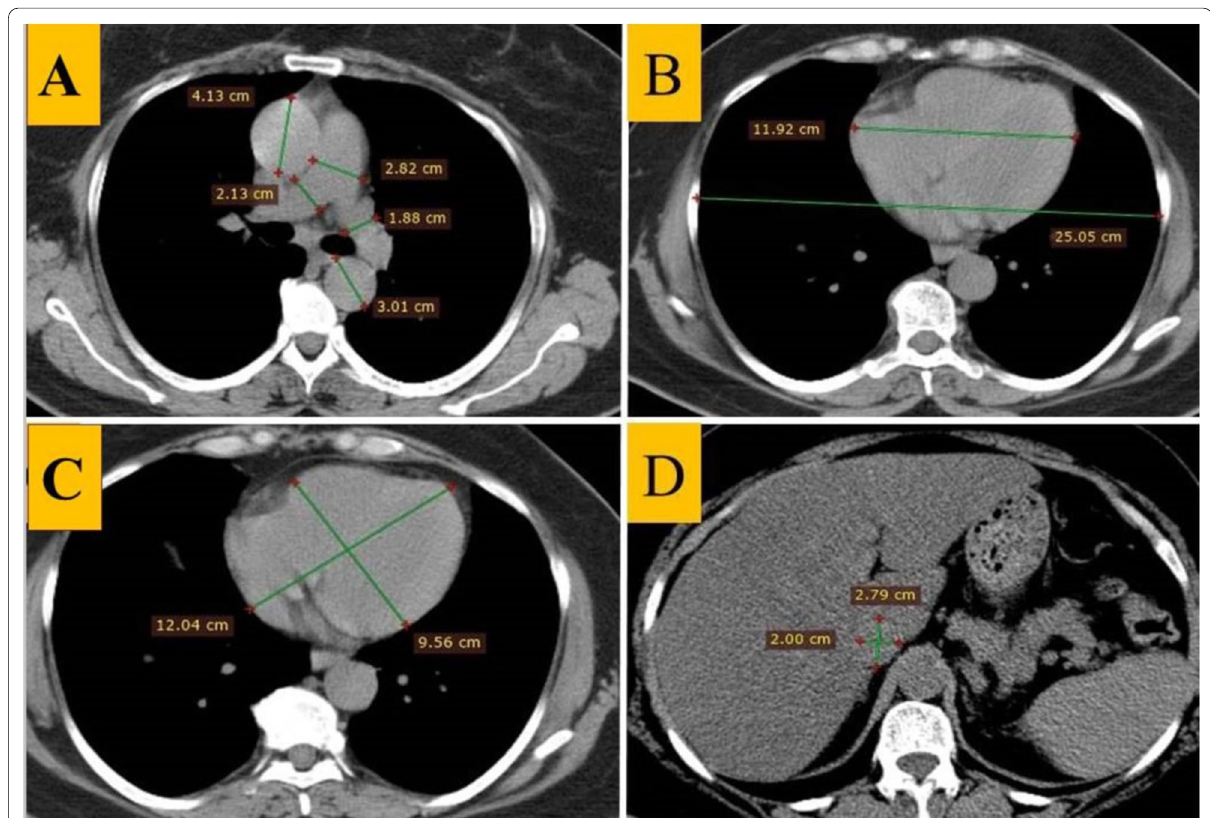
Fig. 1 Methods for measuring the CCT cardiovascular parameters. A Measurements of the diameters of the pulmonary trunk, right, and left pulmonary, ascending, and descending aorta, and calculation of the PA/AA ratio. B Measurements of the heart width and thoracic interval diameters to calculate the CTR. C Measurements of the long and short heart axis and calculation of the long/short axis heart ratio. D Measurements of the transverse and anterior–posterior IVC diameter and calculation of the Tran/AP